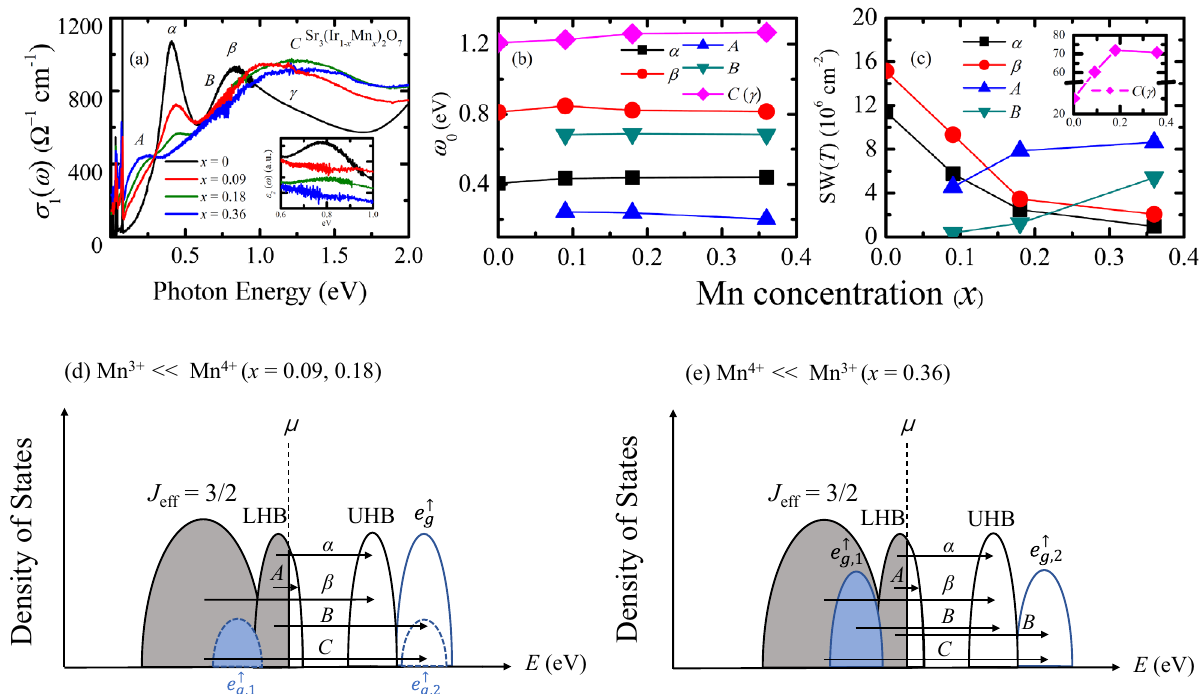
Figure 2. ( a ) Optical conductivity spectra of Sr 3 (Ir 1− x Mn x ) 2 O 7 at 10 K. The inset shows the imaginary parts of the dielectric constant. The spectra are shifted vertically for clarity. ( b ) Doping dependence of the resonance energies of the peaks α , β, A, B, C ( γ ) at 10 K. ( c ) Doping dependence of the spectral weights of the peaks α , β , A, B, C ( γ ). The inset shows the doping dependence of the SW of the peak C . Schematic band diagram of Sr 3 (Ir 1− x Mn x ) 2 O 7 with the cases where ( d ) the Mn 4+ and ( e ) Mn 3+ ions dominate. The bands drawn with dashed ↑ 3+ ions in the x = 0.09 and 0.18 compounds. The e ↑ lines in ( d ) represent the e g ,1 and g ,2 states of the minority Mn LHB (UHB) in ( d ) and ( e ) denotes the J eff = 1/2 lower (upper) Hubbard